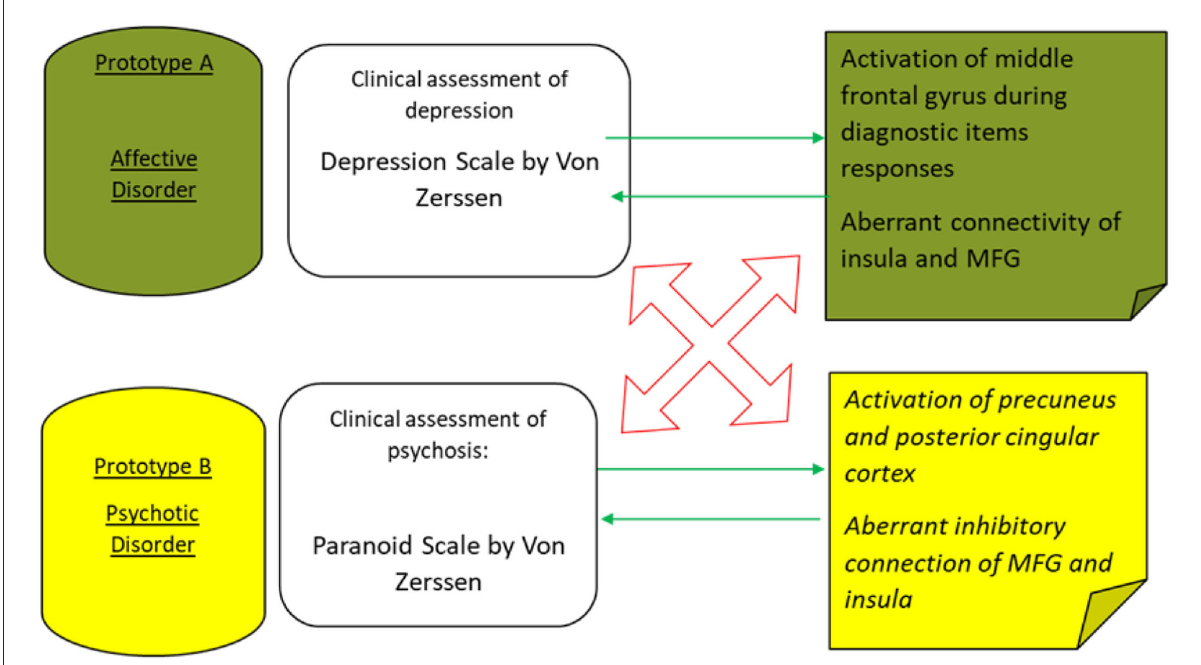
FIGURE2 The main convergent validity (green arrows) and divergent validity (red arrows) are outlined to discriminate on an incremental level between two major prototypes of mental disorders—major depressive episodes and schizophrenic